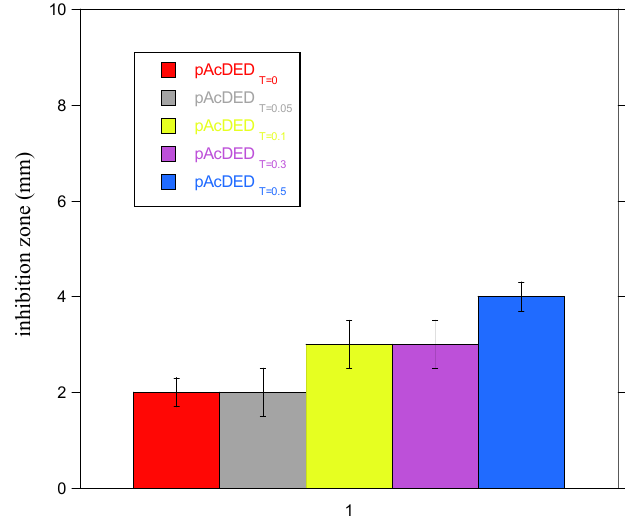
Figure 1. Inhibition zones of bacterial growth of polymers synthesized with different amount of chain transfer agent (T).